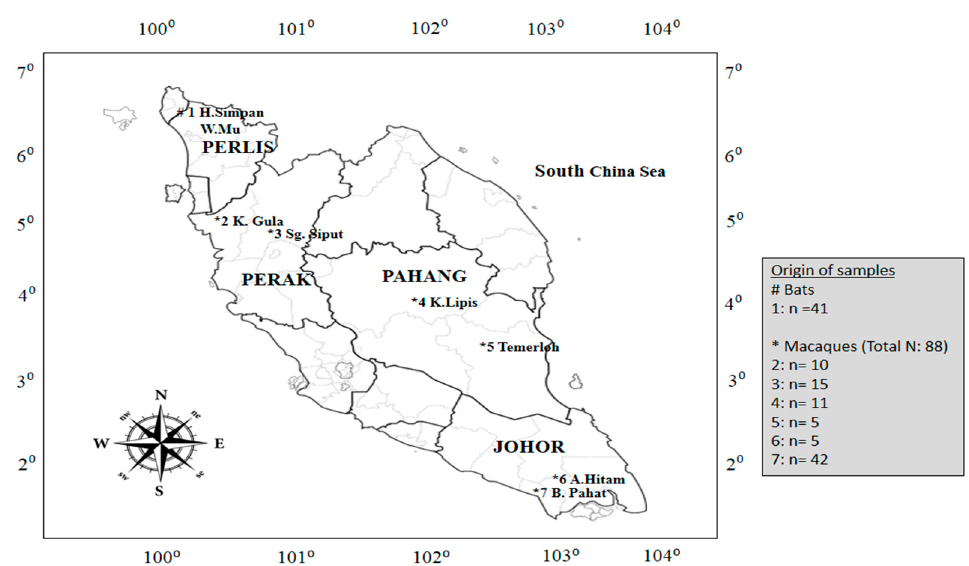
Figure 1. Map of Peninsular Malaysia showing the origin of bat and macaque samples. Note: The hash (#) symbol indicates the origin of bat samples, which were collected from (1) Hutan Simpan Wang Mu located in Perlis state (Northern Malaysia), while the asterisk (*) symbol indicates the origin of macaque samples from (2) Kuala Gula and (3) Sungai Siput located in Perak state (West Coast Malaysia); (4) Kuala Lipis and (5) Temerloh Pahang state (central Malaysia); and (6) Ayer Hitam and (7) Batu Pahat from Johor state (Southern Malaysia). N: Total animals; n: No. of